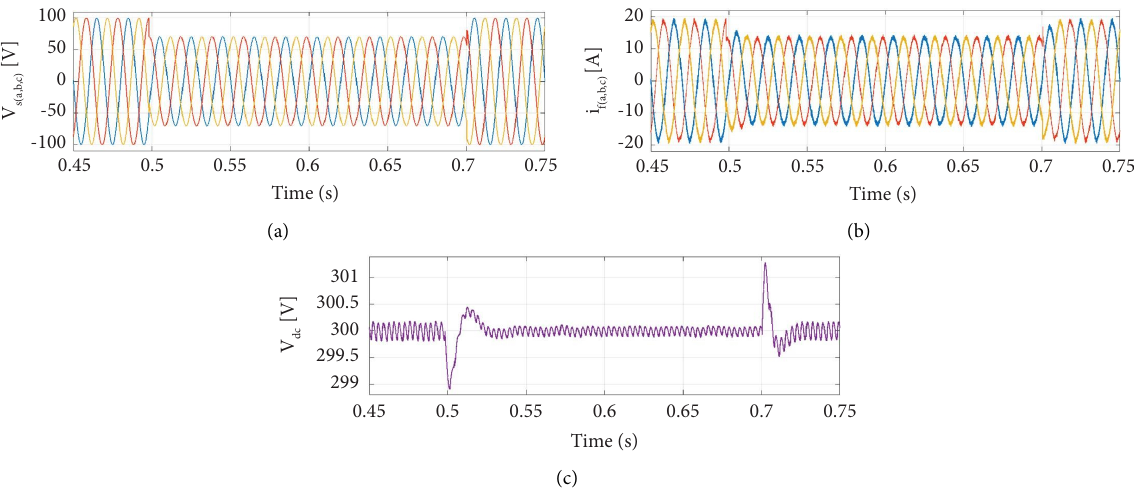
Figure 11: Experimental results for 30% voltage sag with during 0.2s of grid source voltage V